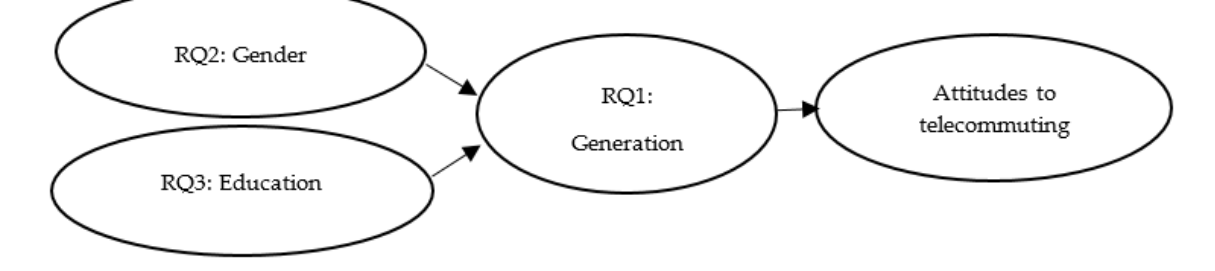
Figure 1. Scheme of the research.